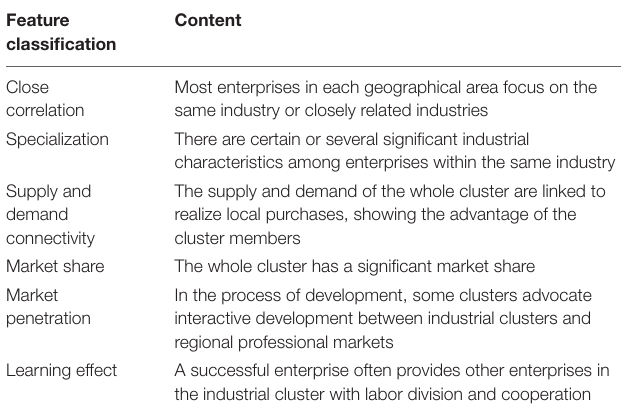
TABLE 1 | Characteristics of industrial clusters in the new